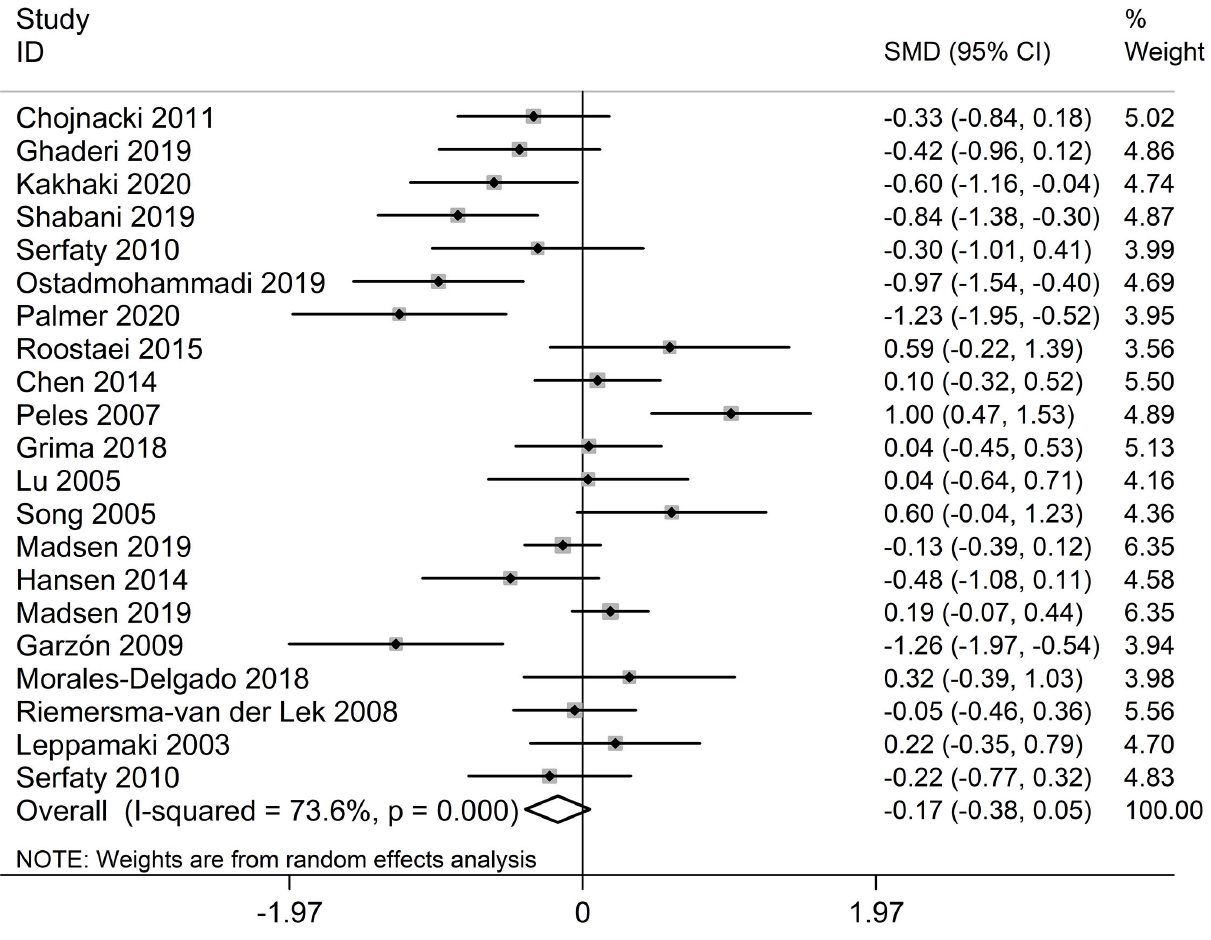
FIGURE 2 | Meta-analysis on therapeutic effect of melatonin depression measured by eight scales. SMD, standardized mean difference; CI, confidence